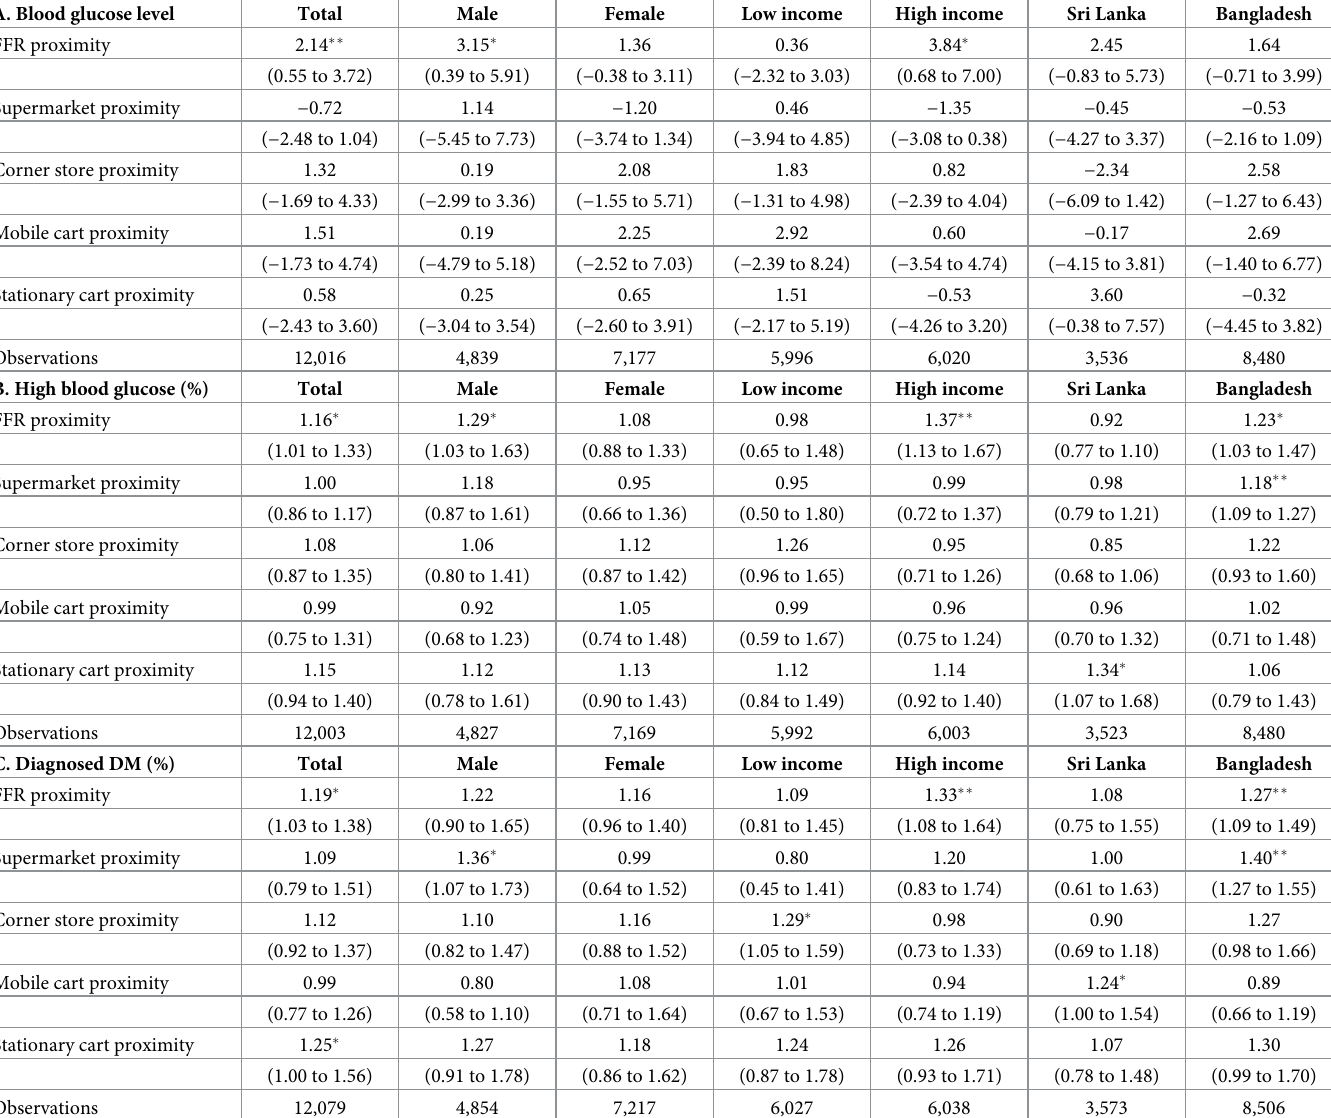
Table 3. Associations between food outlet proximity and fasting blood glucose (OLS coefficients), high blood glucose, and diagnosed DM (AORs). A. Blood glucose